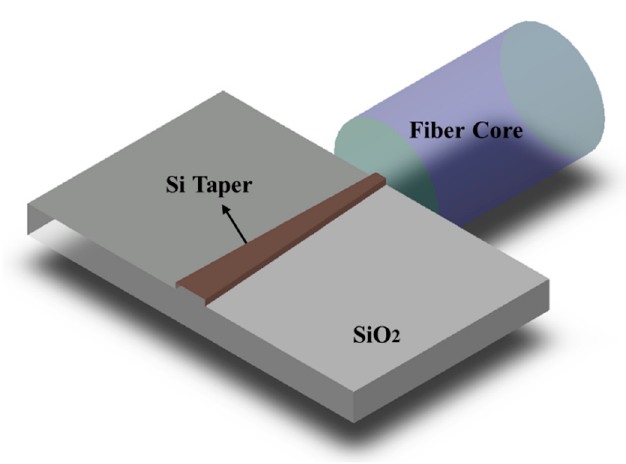
Figure 1. Schematic of optical interconnects between fiber and photonic chip.